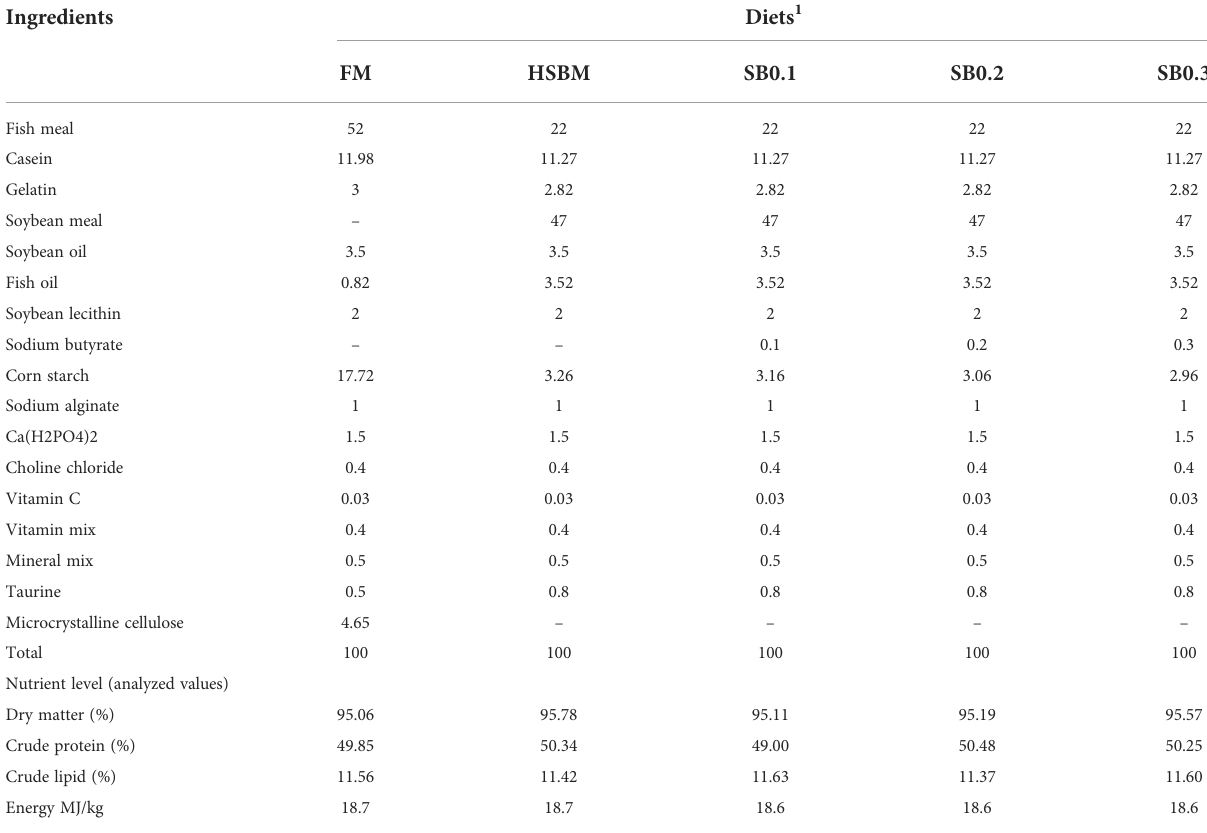
TABLE 1 Formulations and nutrient level on experimental diets of grouper (on an as-fed basis, %). Ingredients